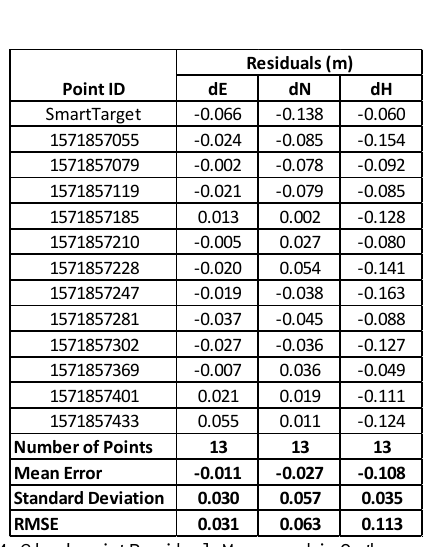
Figure 10: GCP in Orthomosaic